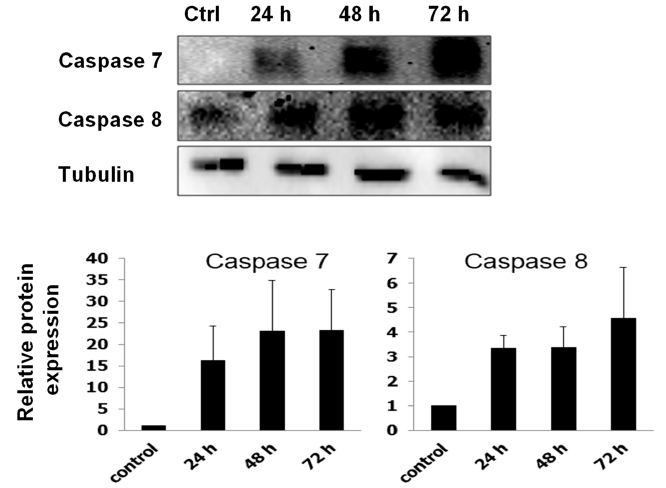
Figure 5. RTEAL increases the protein expression of caspases. MCF-7 cells were treated with 28 µg/mL of RTEAL for 24, 48 and 72 h. Representative Western blot and relative protein expression